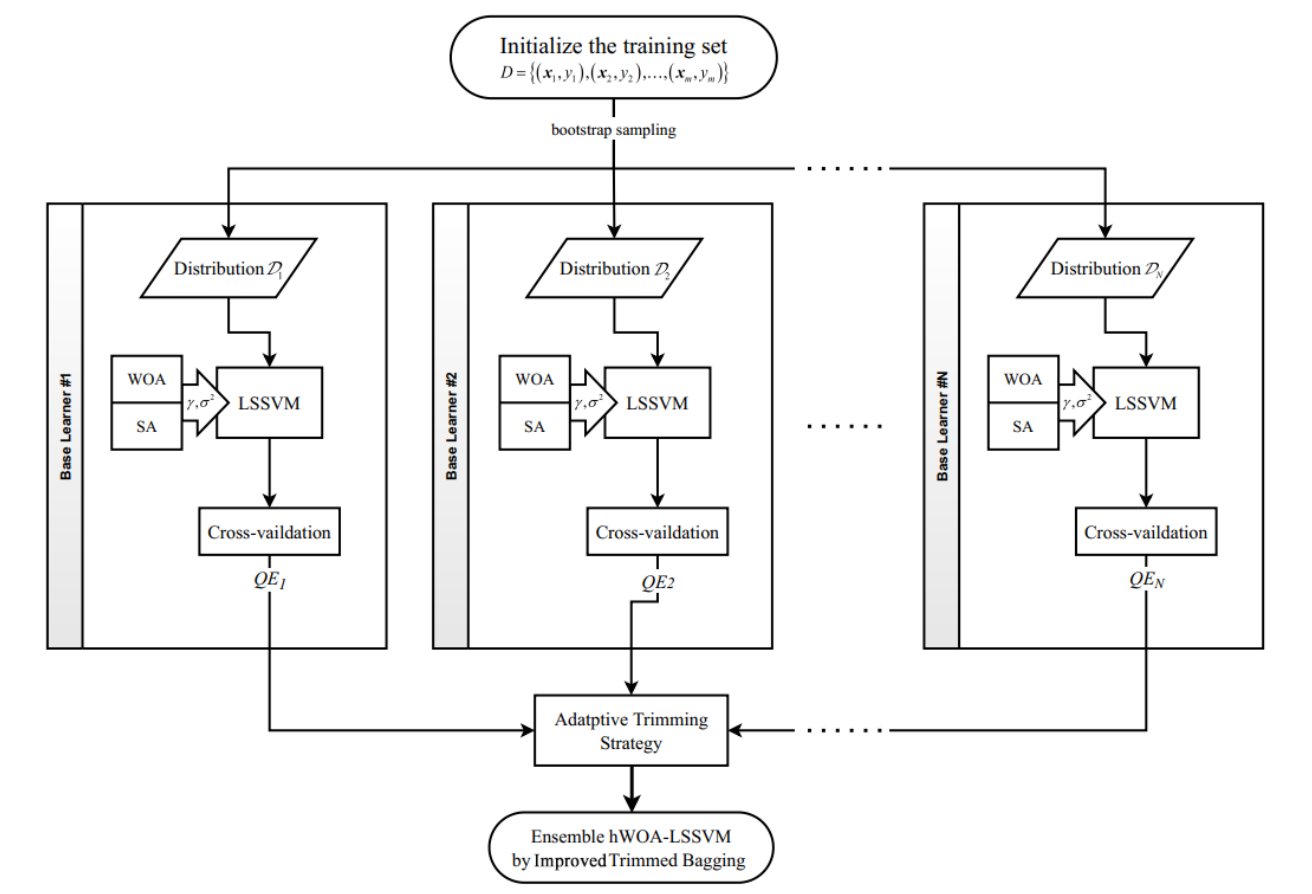
Figure 1. Flowchart of ensemble hWOA-LSSVM based on improved trimmed